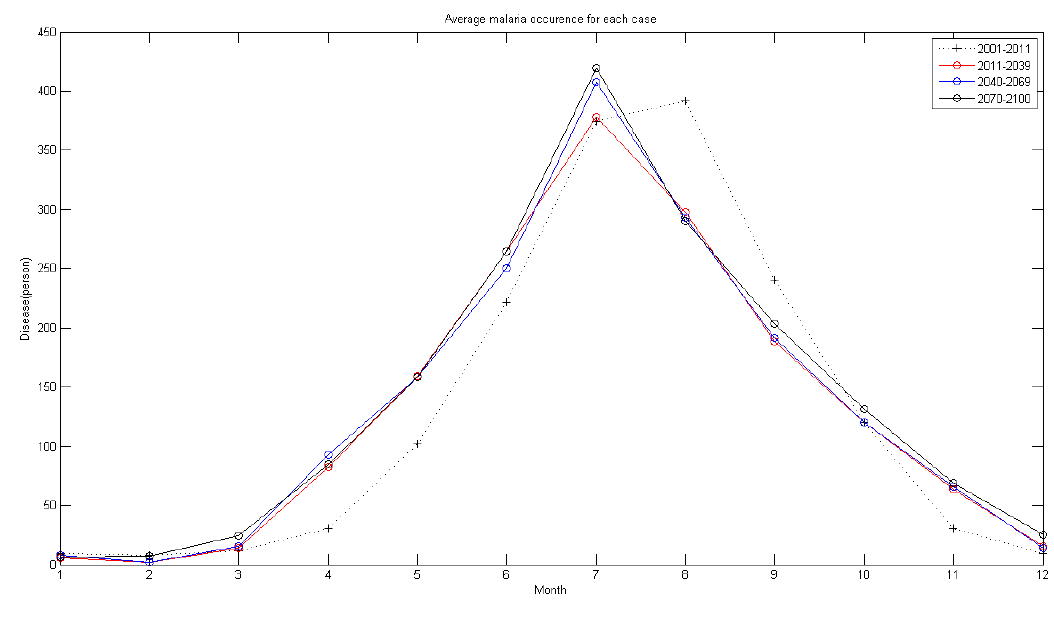
Figure 11. Monthly malaria occurrence plot for each